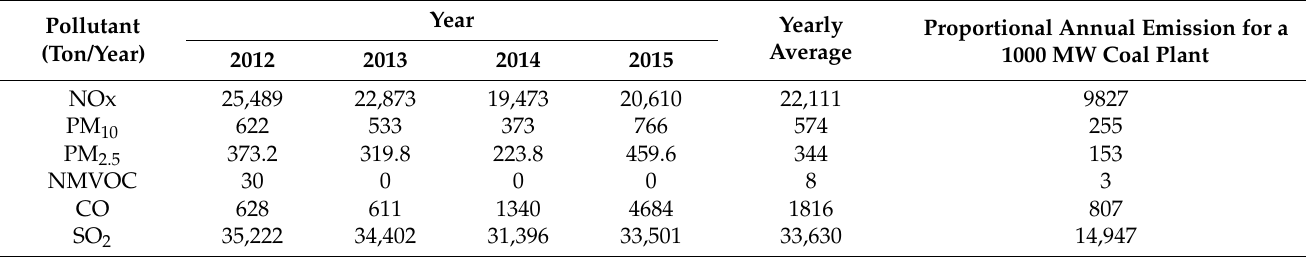
Table A27. Emissions from the 2250 MW Rotenberg coal power